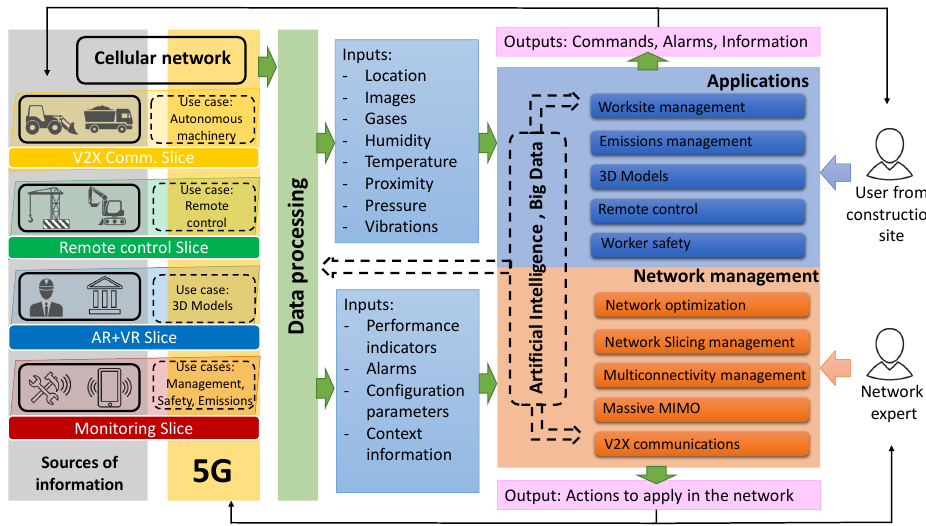
Figure 2. System architecture for 5G in